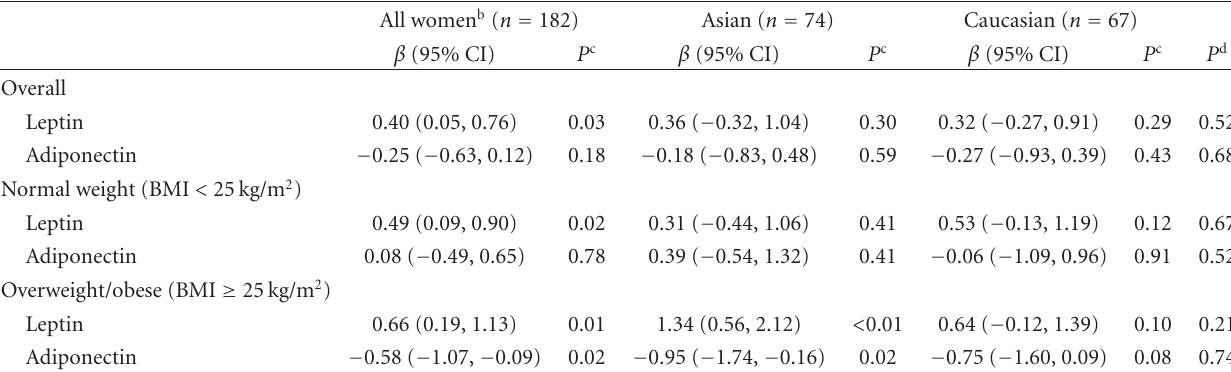
Table 2: Association of leptin and adiponectin with CRP by ethnicity a